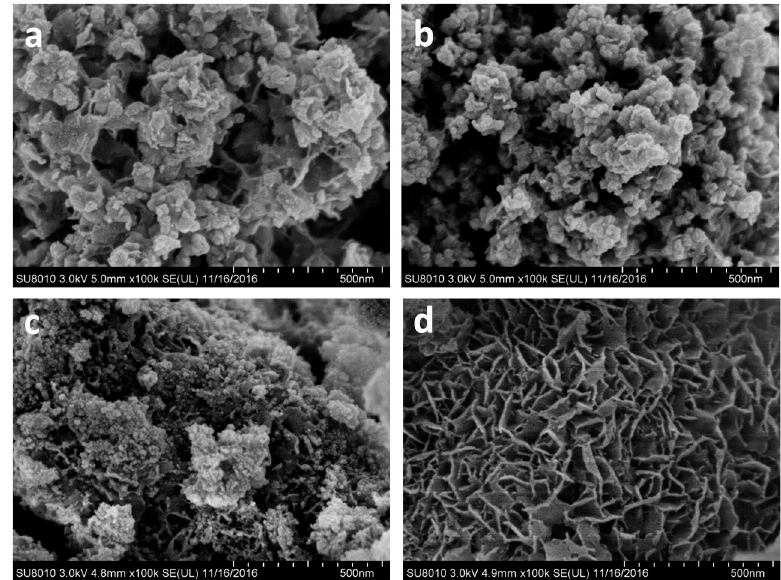
Figure 1. SEM (scanning electron microscopy) micrographs of Co–B particles prepared in ( a ) water; ( b ) methanol; ( c ) acetone; and ( d ) acetonitrile.